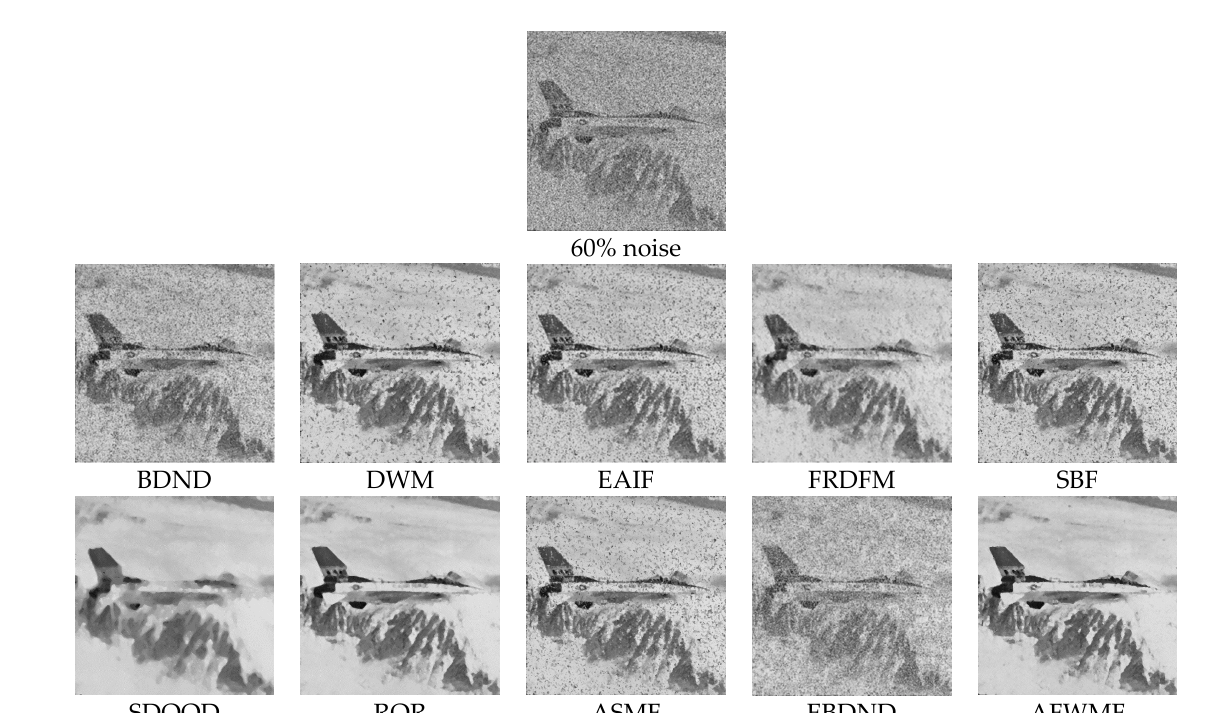
Figure 16. Repair map with a 60% random value of impulse noise for the Gold Hill image.